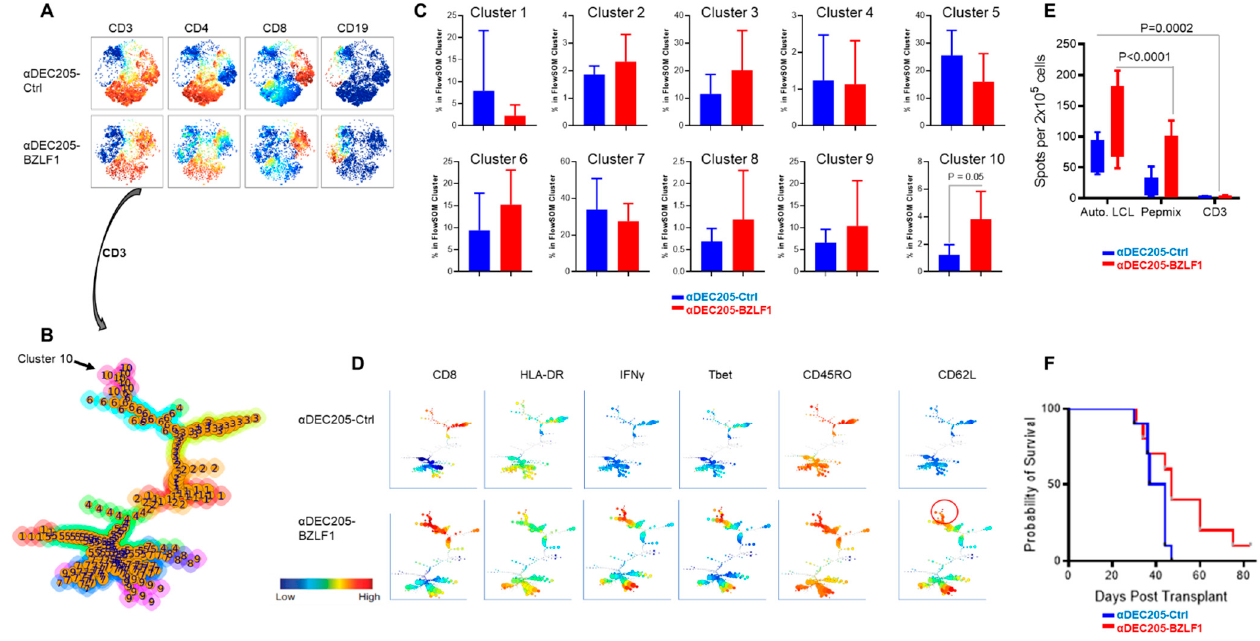
Figure 6. In vivo evaluation of the α DEC205-BZLF immunogen; ( A ) The viSNE maps, colored by the intensities of individual immune marker expression (CD3, CD4, CD8, and CD19); ( B ) FlowSOM minimal spanning tree (MST) on HuCD3+ T-cells showed both HuCD4+ T-cells and HuCD8+ T-cells; ( C ) Percentage of T-cell population from each vaccination group ( α DEC205-Ctrl CoCx and α DEC205-BZLF) in each FlowSOM meta-cluster; ( D ) FlowSOM minimal spanning tree (MST) colored by the intensities of individual immune marker expression (CD8, HLA-DR, IFN γ , Tbet, CD45RO, and CD62); ( E ) Ex-vivo immune responsiveness to recall antigens (autologous LCLs, BZLF1 pepmix, and anti-TCR) by ELISpot; ( F ) Log-rank test: BZLF vaccine significantly delayed lymphoma development.